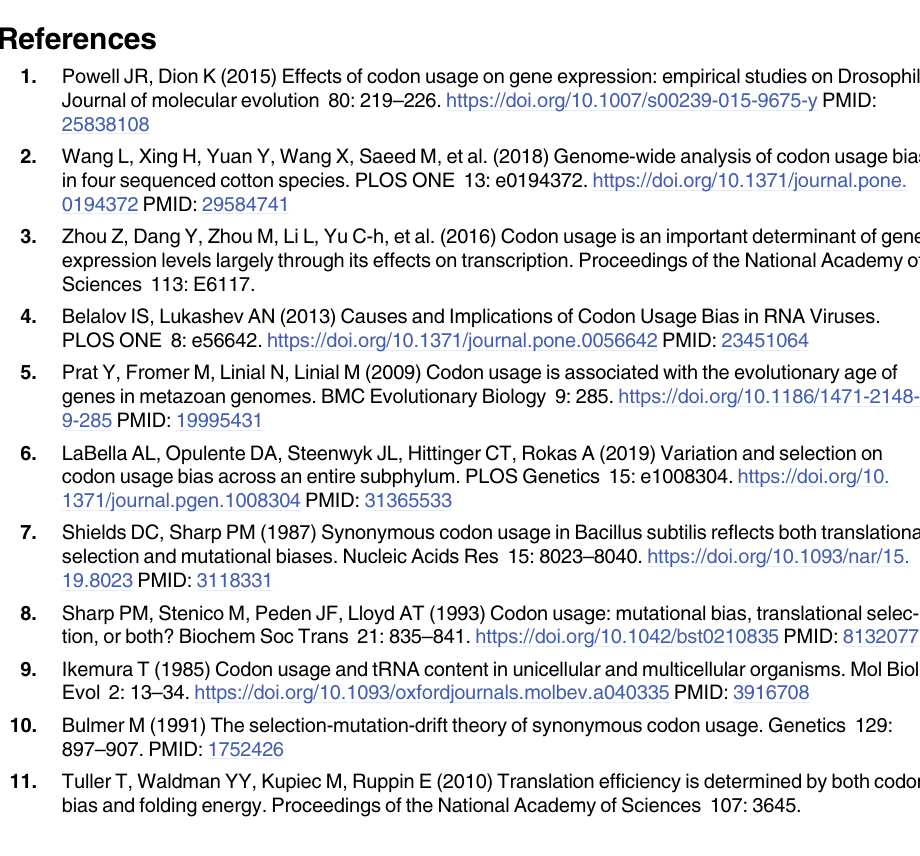
S2 Fig. The CDS of ftsZ from the four bacterial species is depicted here.